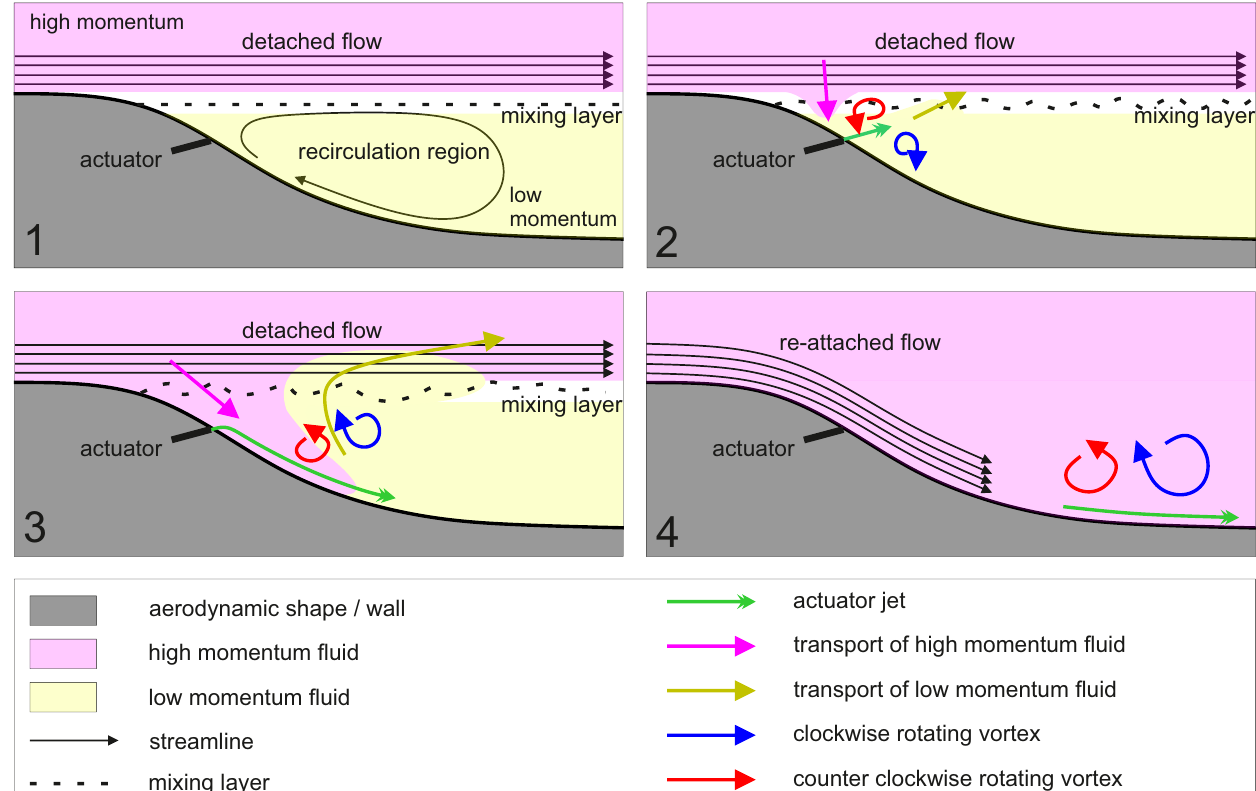
Figure 1. Simplified 2D sketch of the PJA working